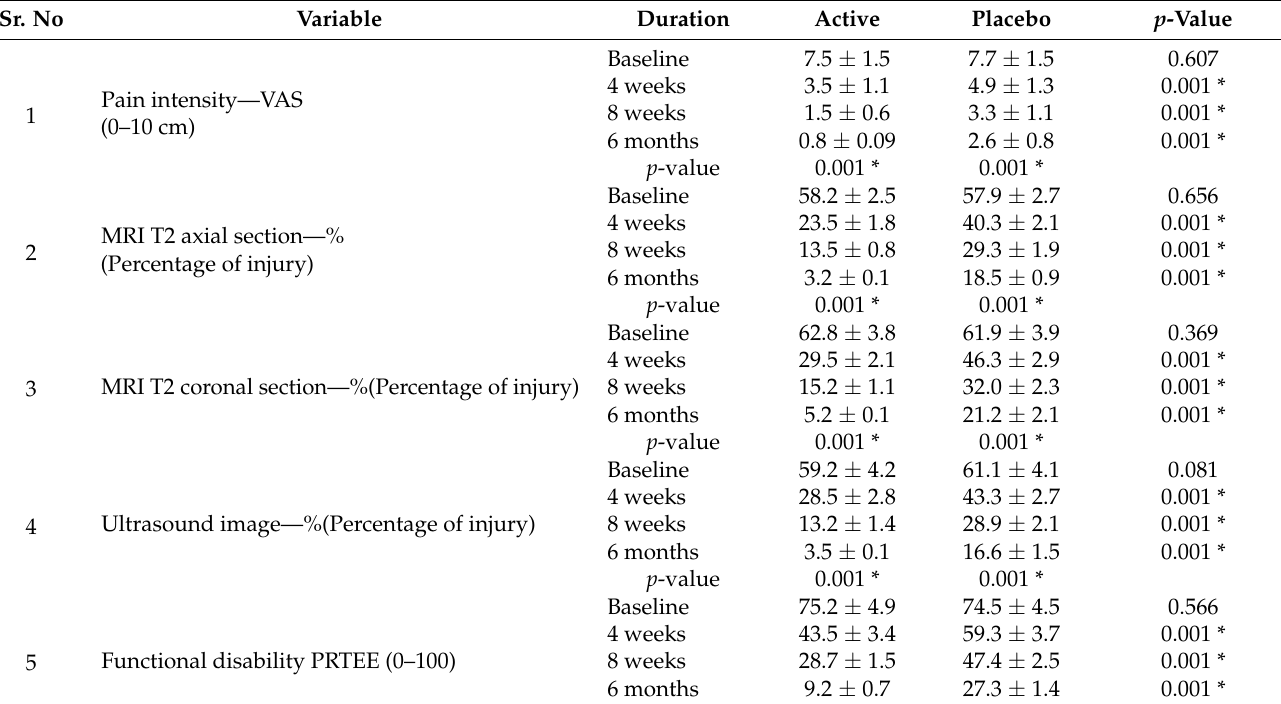
Table 2. Pre- and post-primary outcome measures of active and placebo ESWT